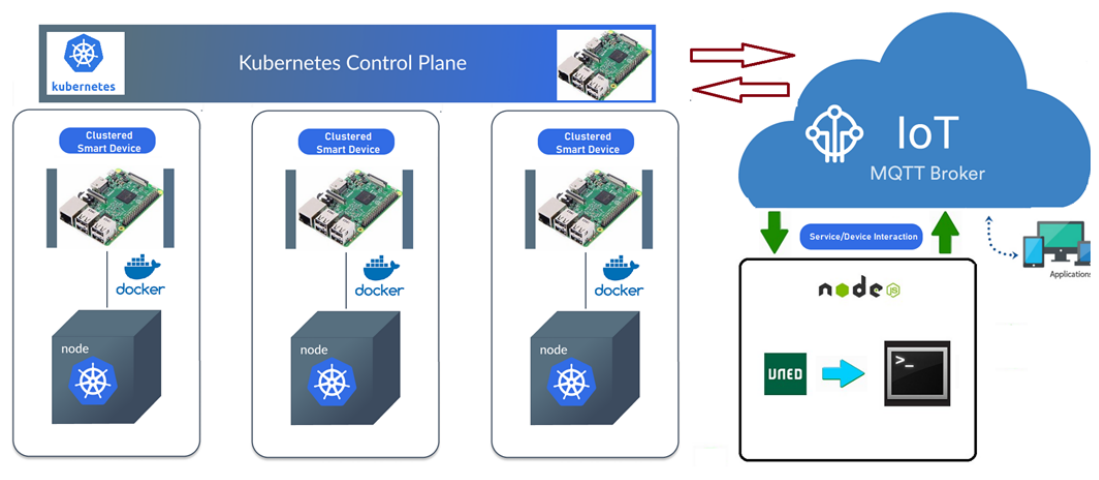
Figure 5. Technical solution for Labs of Things at UNED